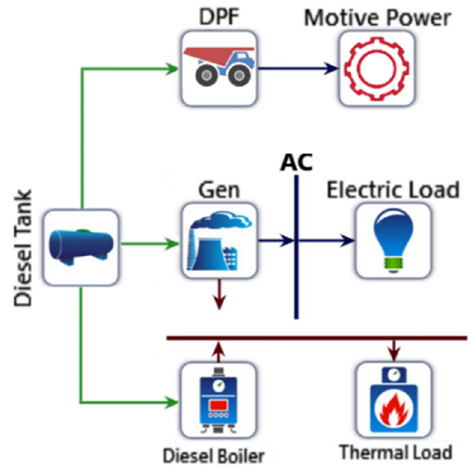
Figure 2. All-diesel-based system configuration.